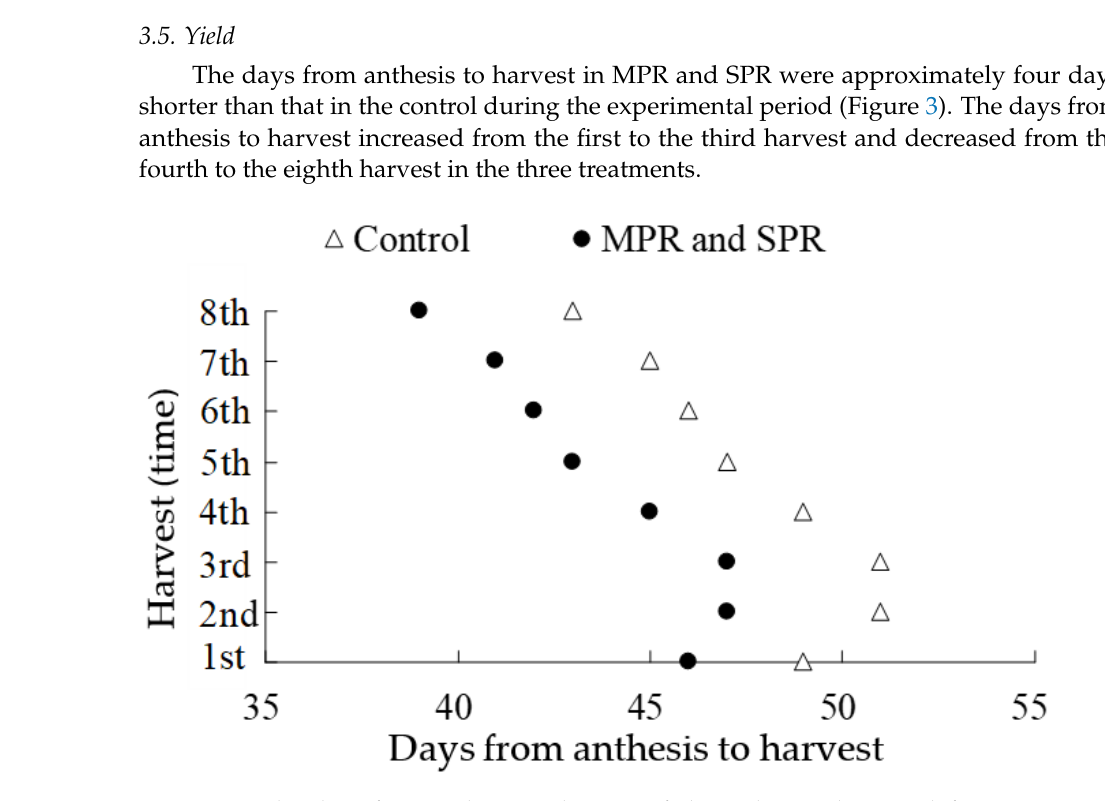
Figure 3. Figure 3. The days from anthesis to harvest of the eight-time-harvested fruits in control, MPR, and SPR. MPR: moderate wilting – partial recovery treatment. SPR: severe wilting – partial recovery treat- recovery